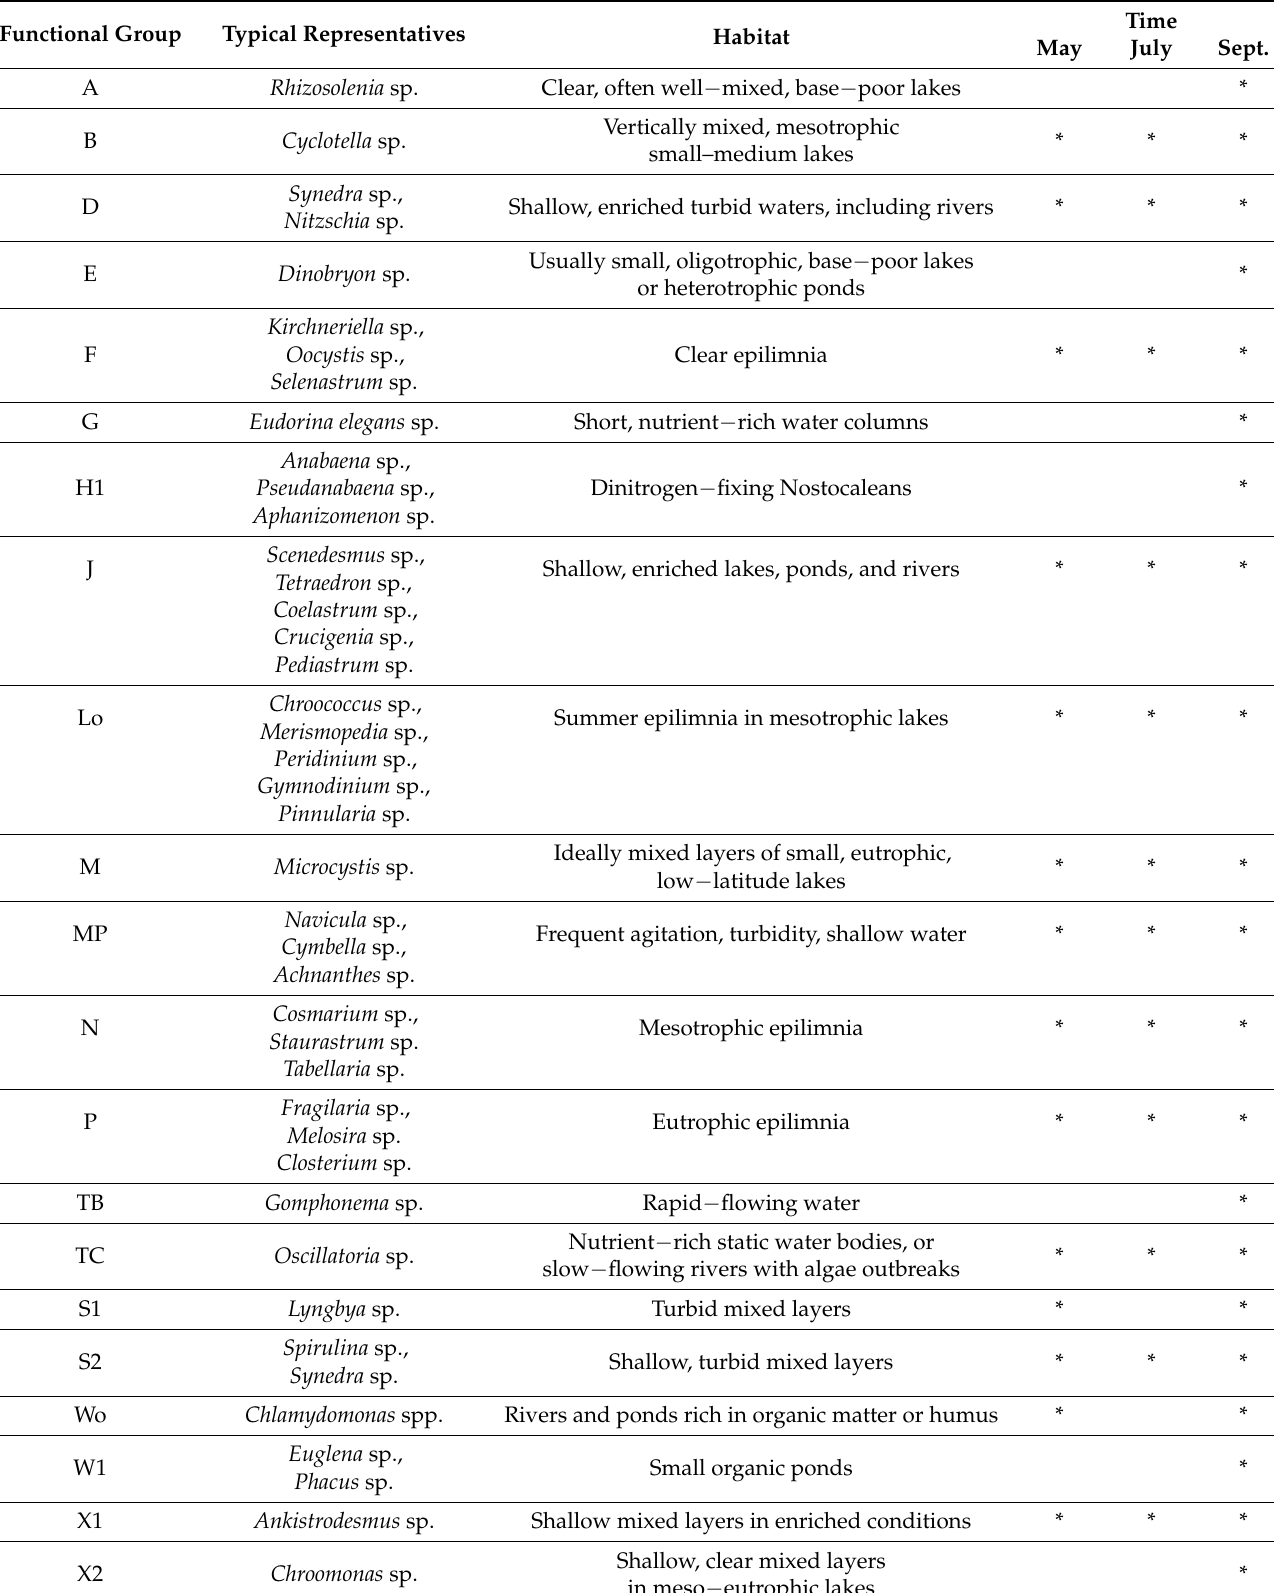
Table 2. Functional group composition of phytoplankton in Nanhai